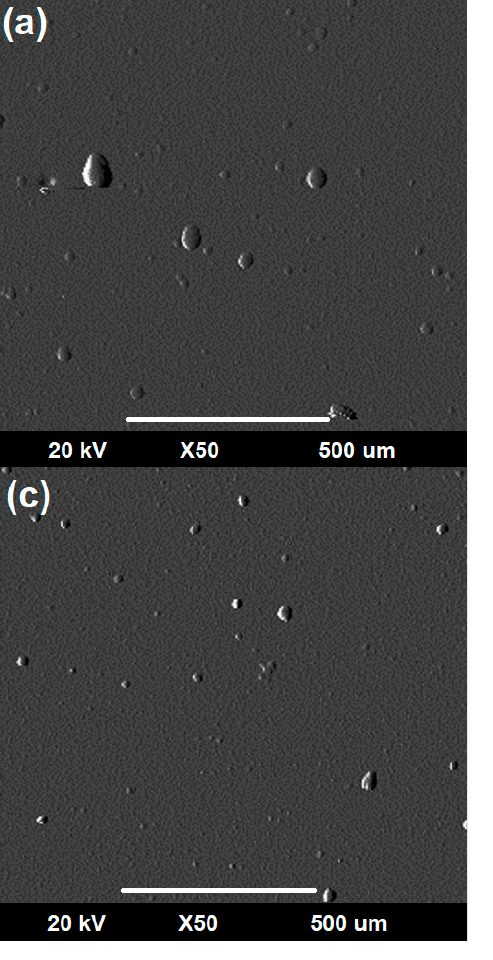
Figure 13. SEM micrographs after 30° impact angle corro-erosive testing for coatings ( a ) TaC, ( b ) HfC, ( c ) (Ta 70 -Hf 30 -C) and ( d ) (Ta 30 -Hf 70 -C).